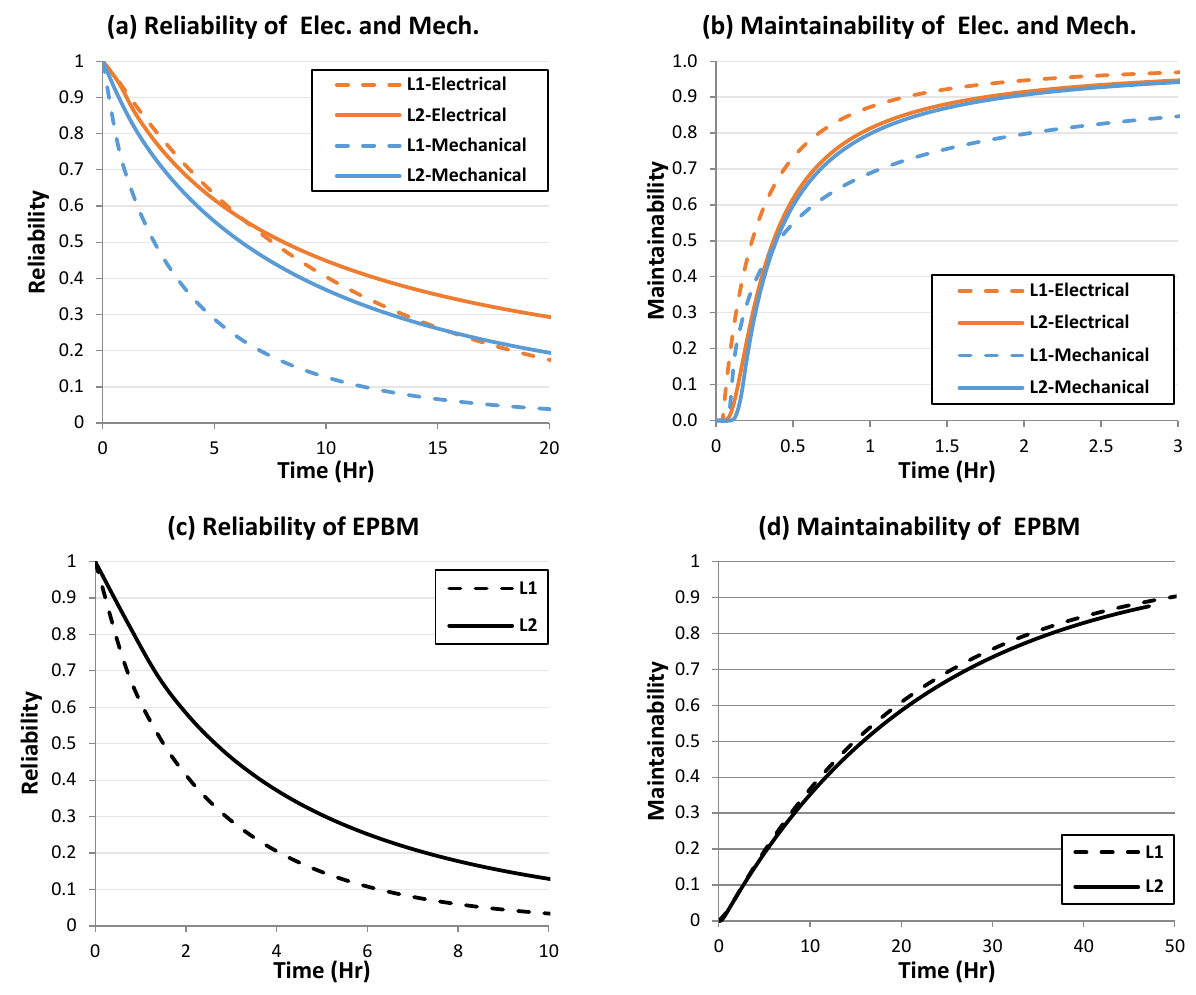
Figure 12. Reliability ( a , c ) and Maintainability ( b , d ) of EPBM and two subsystems in Lines 1 and 2.